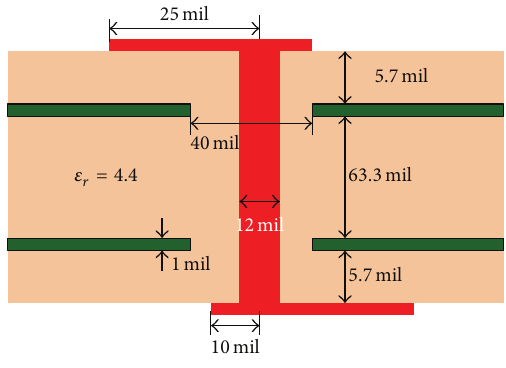
Figure 9: Side view of single via